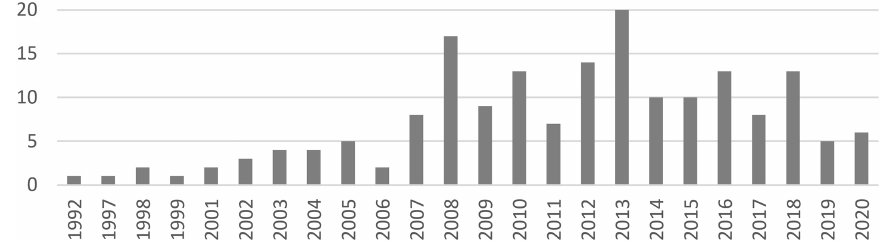
Fig. 1. Number of systems regarding their first usage